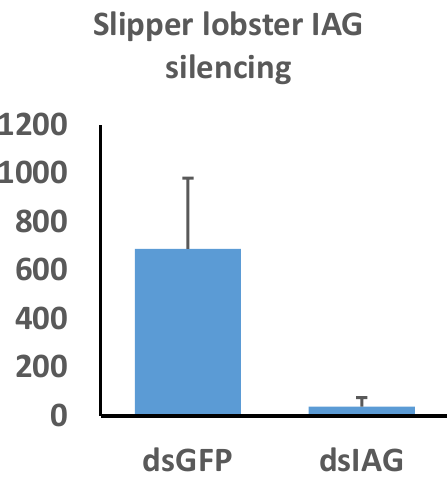
Figure 7. The effects of insulin androgenic gland hormone (IAG) silencing on IAG expression in Thenus australiensis . Expression relative to 18s is displayed on the y-axis, while dsRNA treatments are displayed on the x-axis. Juvenile male slipper lobsters were injected once with GFP dsRNA or Taus-IAG dsRNA. Then, 24 h later, the 5th walking legs of the animals were dissected and RNA was extracted and reverse-transcribed to cDNA. Following a qPCR assay, expression relative to 18 s showed significant IAG knockdown in the group injected with Taus-IAG dsRNA (~95%), indicative of robust and highly effective gene silencing.